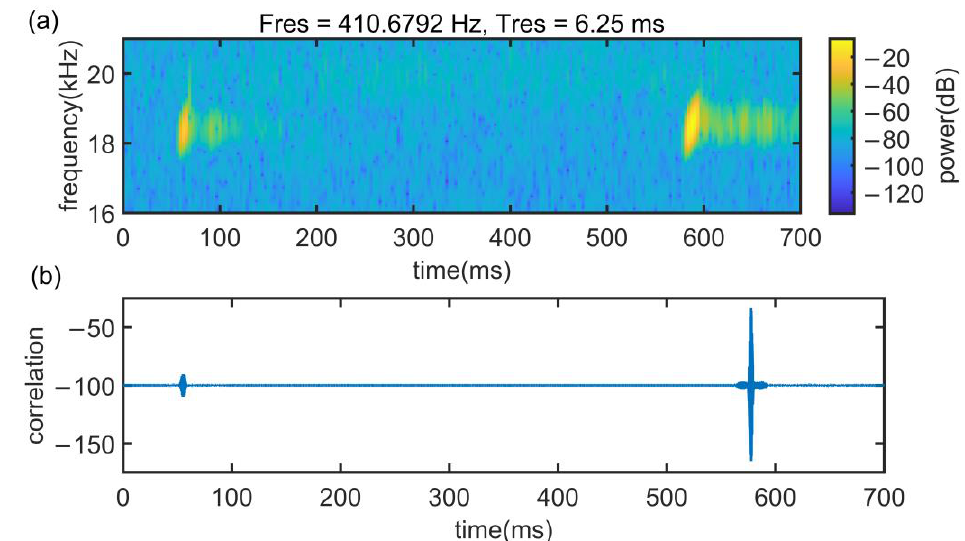
Figure 22. Signal propagation characteristics in case 1. ( a ) Signal spectrogram and ( b ) cross-correlation results.